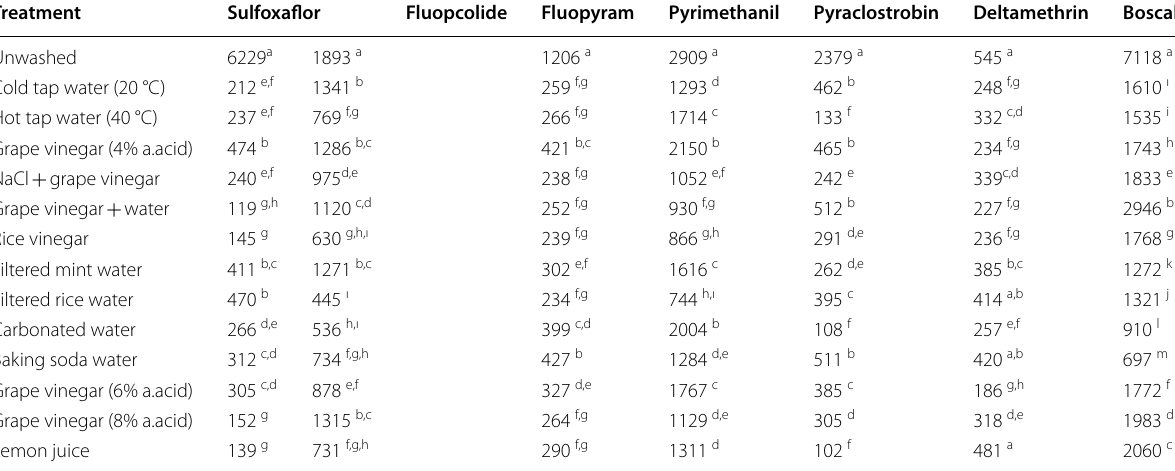
Different letters in a column indicating a statistically significant difference ( p <